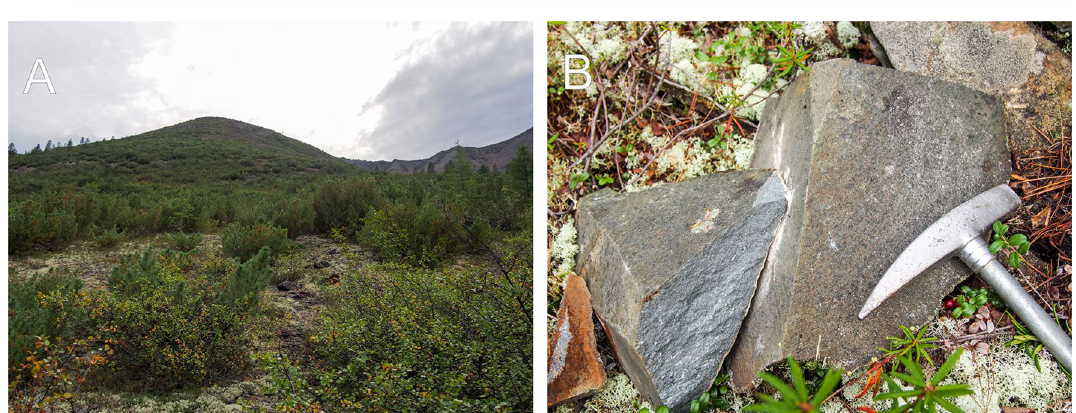
Figure 3. ( A ) A view of the sample location, looking NNW. ( B ) Dolerite sample